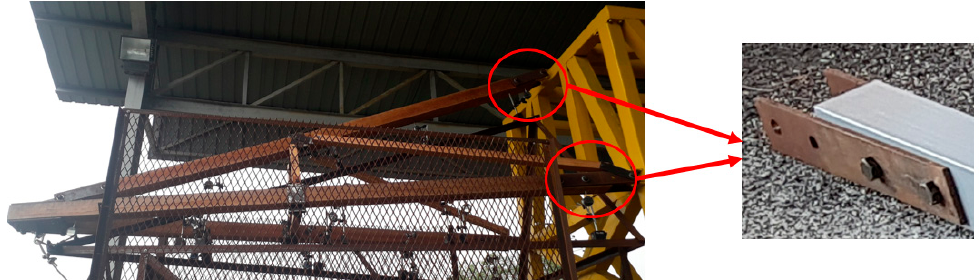
Figure 4. Connection of cross-arm to steel tower using steel plate fittings.